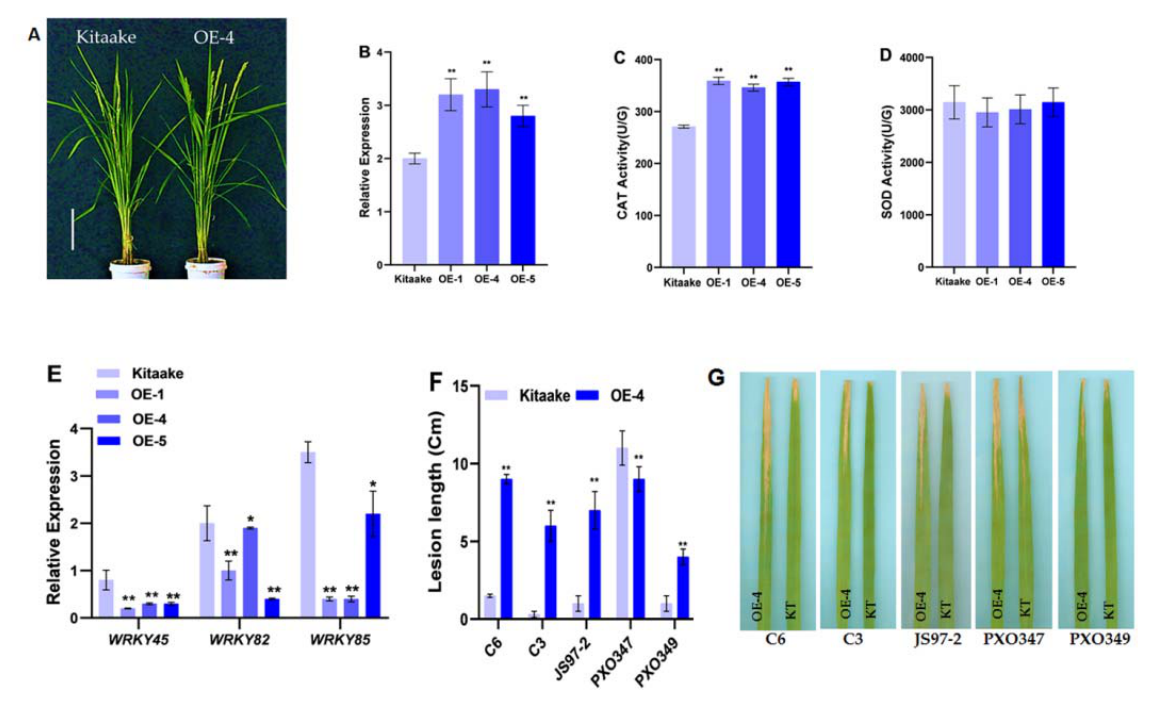
Figure 5. Overexpression analysis of OsHCAR in Kitaake background. ( A ) Phenotypes of Kitaake and T 1 Overexpression line (OE-4). ( B ) Relative expression of OsHCAR in Kitaake and different OE lines. ( C , D ) Enzyme activities of CAT and SOD ( E ) Expression levels of Pathogenesis related genes. ( F ) Lesion length (cm). ( G ) Leaf phenotypes of Kitaake and OE-4 plants after inoculation with bacterial blight pathogens. Data are means ± SD of three biological replicates ( B – E ) and five biological replicates ( F ) (Student’s t -test: * p < 0.05; ** p < 0.01).